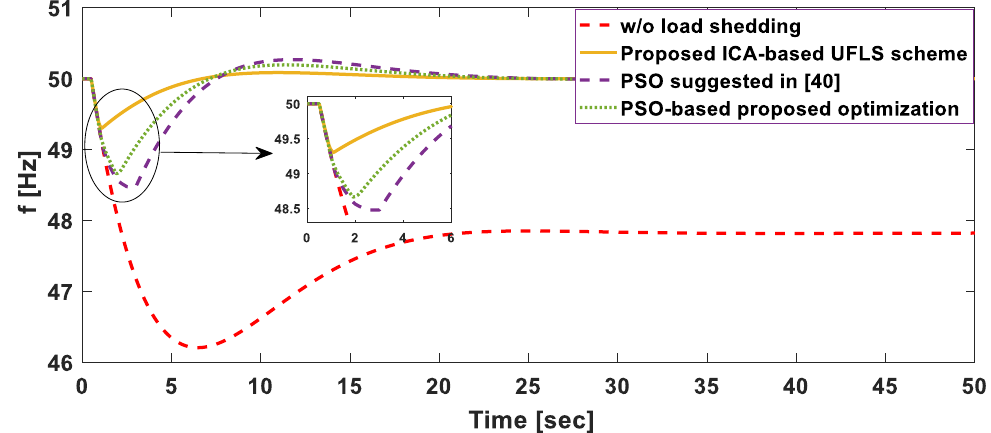
Figure 14. Frequency behavior of the proposed UFLS technique compared to others optimization-based techniques: PSO and